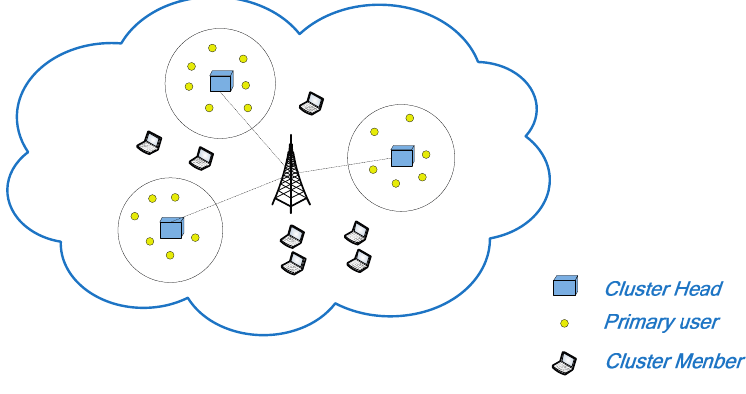
Figure 2. A cognitive radio sensor networks with the primary